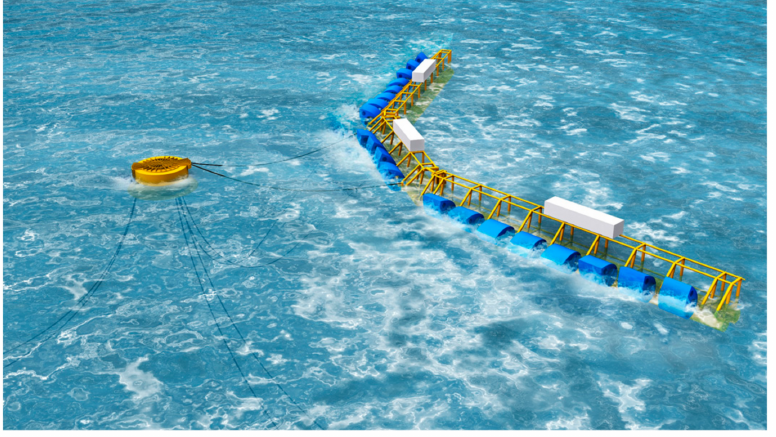
Figure 1. Layout of arrayed WEC platform and mooring buoy system configurations.